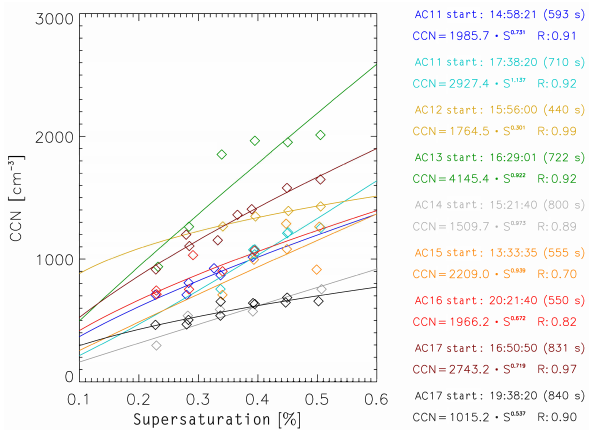
Figure 8. CCN 1 (red dots) and CCN 2 (black dots) measurements for a segment of flight AC17 on 27 September 2014. The abscissa shows the measurement time in UTC. The blue line indicates the altitude in meters above sea level and is labeled on the left ordi- nate (along with CCN 1 and CCN 2 ). S 1 and S 2 measurements in % are indicated by the orange and green lines, respectively (both are labeled on the right ordinate). The cyan dots on the blue line in- dicate cloud penetrations (i.e., when cloud droplet concentrations are greater than 20cm − 3 ). In this case, cloud base heights were ob- served around 2300m above ground.